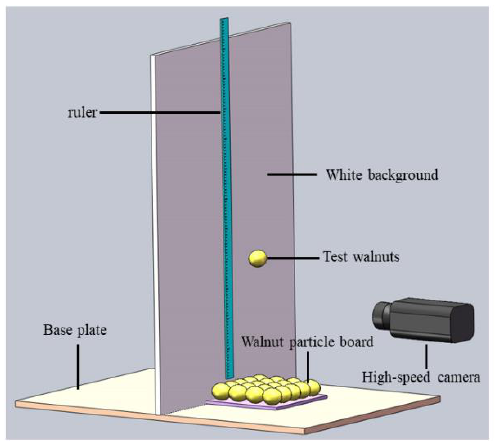
Figure 4. Walnut–walnut collision recovery coefficient measurement test. Figure 4. Walnut – walnut collision recovery coefficient measurement test.